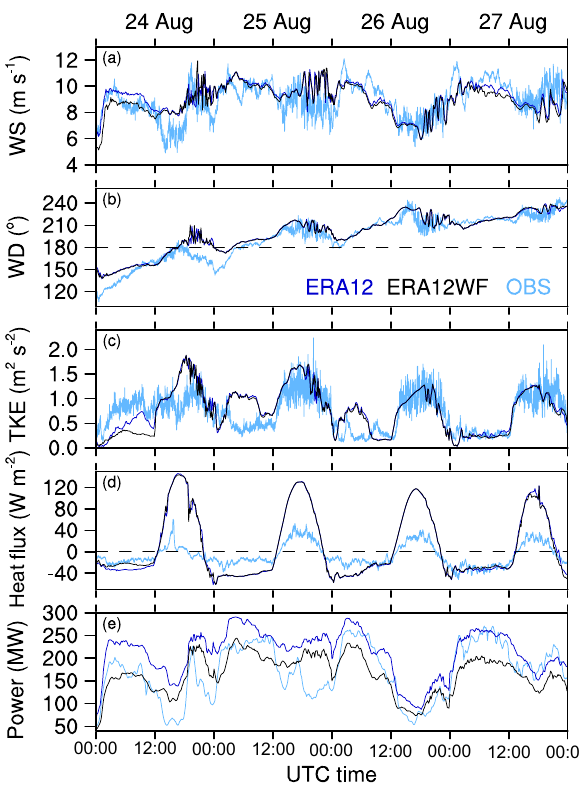
Figure 7. Time series of hub-height WS (a) , hub-height WD (b) , hub-height TKE (c) , surface sensible heat flux (d) , and total wind- farm power (e) from the simulations (ERA12, in blue; ERA12WF, in black) and the measurements (in light blue). The simulated values are interpolated to hub height in the grid cell closest to the WC. In (b) , the horizontal dash line marks the WD of 180 ◦ . In (d) , the horizontal dash line marks the heat flux of 0Wm − 2 .